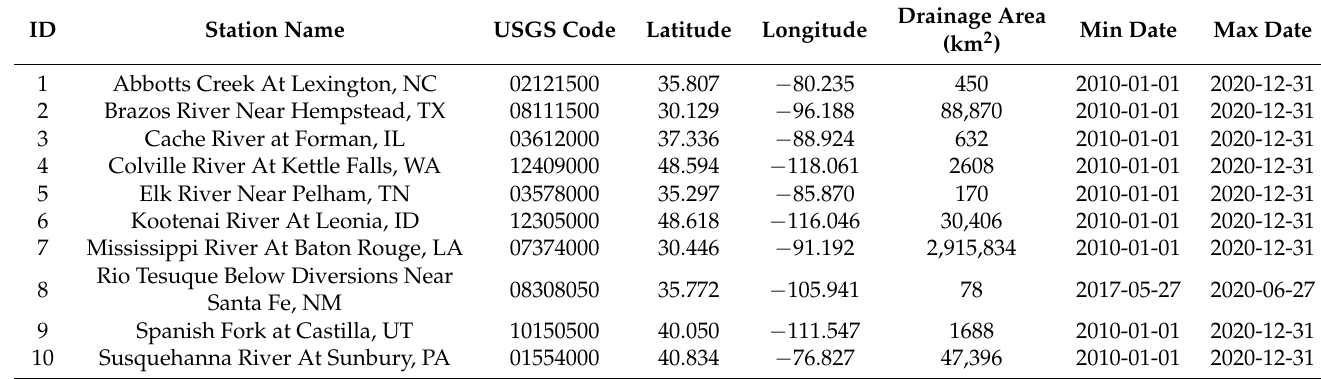
The measurement data for the US were obtained using USGS API (https://waterservices. usgs.gov/rest/, accessed on 1 June 2022). The discharge was obtained in cubic feet per second (ft 3 /s) and stage in feet (ft) and converted to meters per second (m 3 /s) and meters (m) for consistency. Table 2 lists the stations with their USGS code and location. Table 2. List of the stations used in the US with their location. The ‘ID’ column maps to the stations shown in Figure 2. The ‘Min Date’ and ‘Max Date’ represent the earliest and latest stage-discharge pair available for the